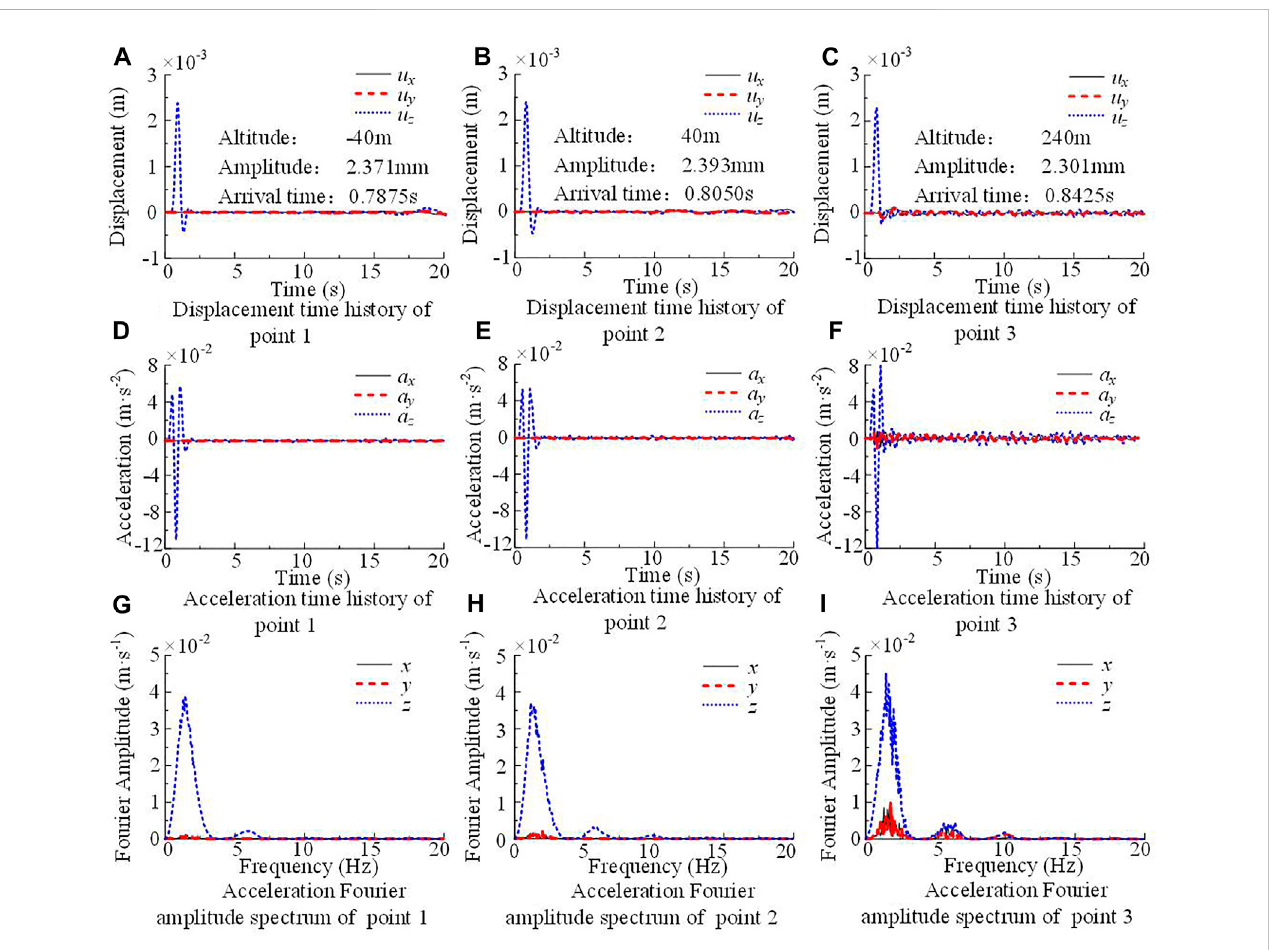
FIGURE 9 Displacement, acceleration time history curve and acceleration Fourier spectrum of observation points with P-wave